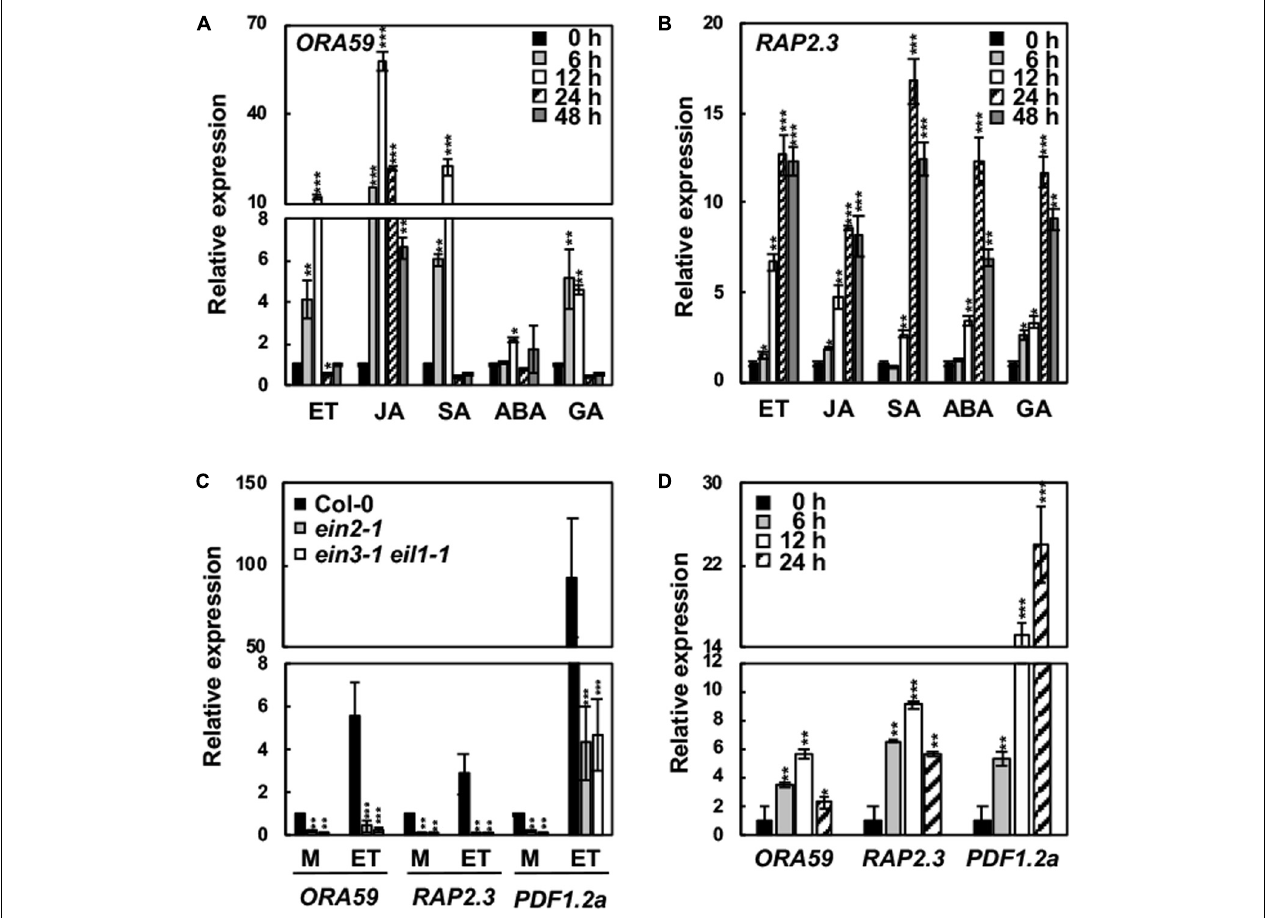
FIGURE 2 | Hormone responses of ORA59 and RAP2.3 expression. (A,B) Expression of ORA59 (A) and RAP2.3 (B) in response to hormone treatments. (C) Expression of ORA59 and RAP2.3 in ein2 and ein3 eil1 backgrounds. (D) Expression of ORA59 and RAP2.3 in response to P. carotovorum inoculation. Four-week-old plants were treated with ET (1.5 mM), MeJA (50 µ M), SA (1 mM), ABA (10 µ M), or GA (10 µ M) for the indicated times in (A,B) , with 0.1% DMSO (mock) or ET (1.5 mM) for 6 h in (C) , and with P. carotovorum (10 4 cfu/mL) for the indicated times in (D) . The values represent means ± SD from three independent experiments. Asterisks indicate significant differences from 0 h treatment (A,B,D) and Col-0 (C) ( t- test; ∗∗ P < 0.01; ∗∗∗ P <